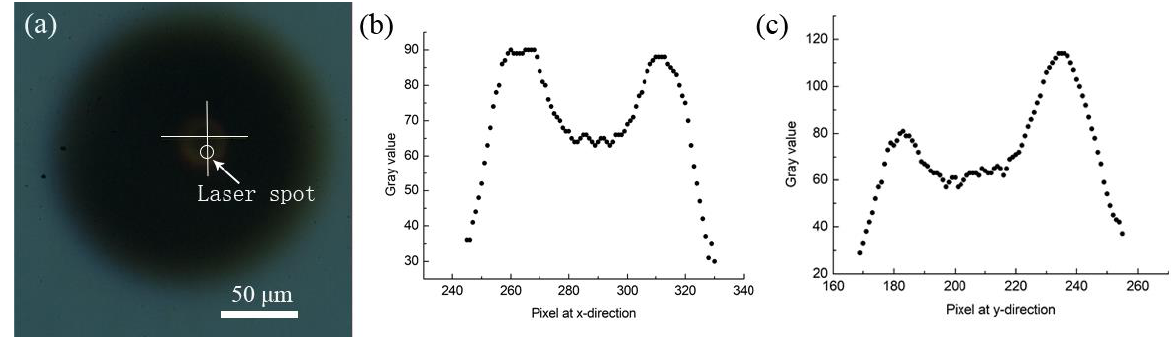
Figure 11. Flame structure of individual Mg microparticle, ( a ) flame picture at 118.27 ms (Figure 10 b), ( b ) gray values along central horizonal line, ( c ) gray values along central vertical line inside the flame ring structure.